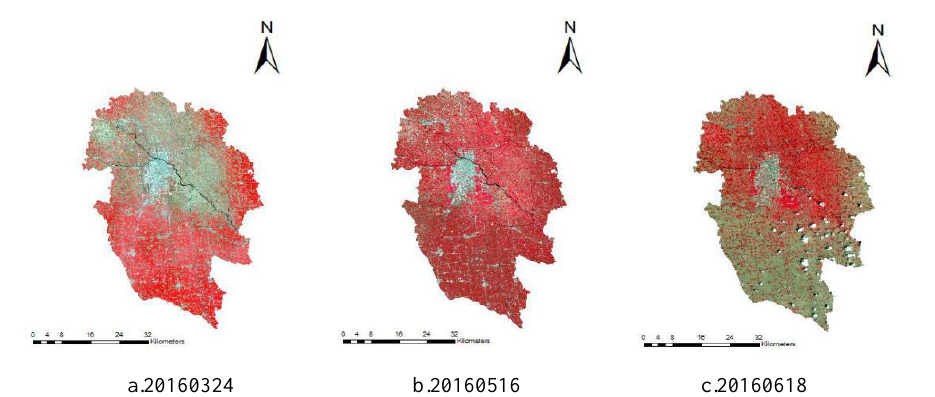
Figure 2 Preprocessing results of remote sensing images in the research